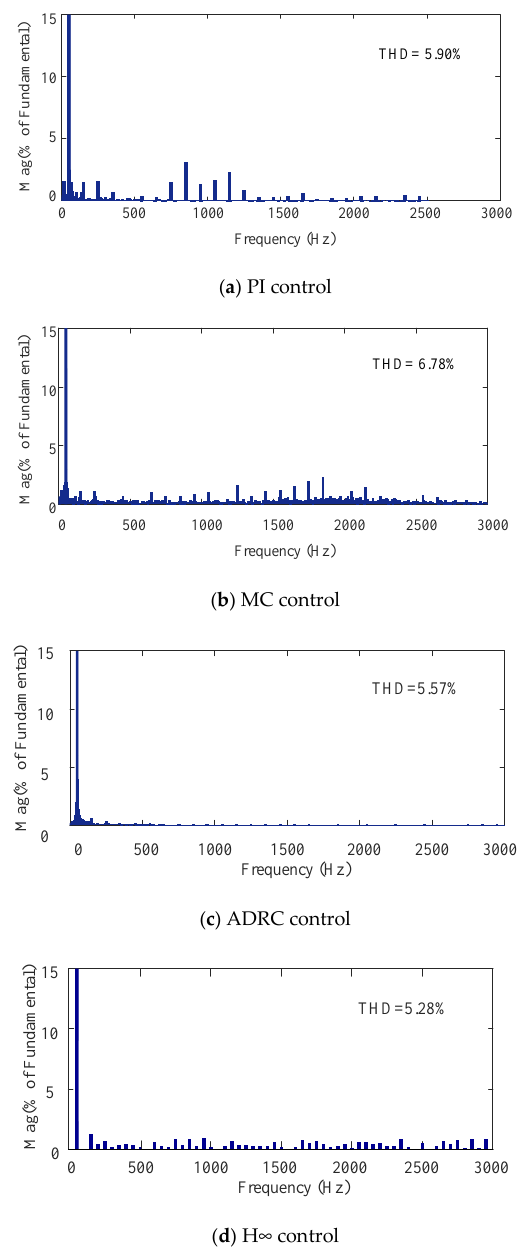
Figure 9. Fast Fourier transform (FFT) results of the input current. THD: total harmonic distortion.